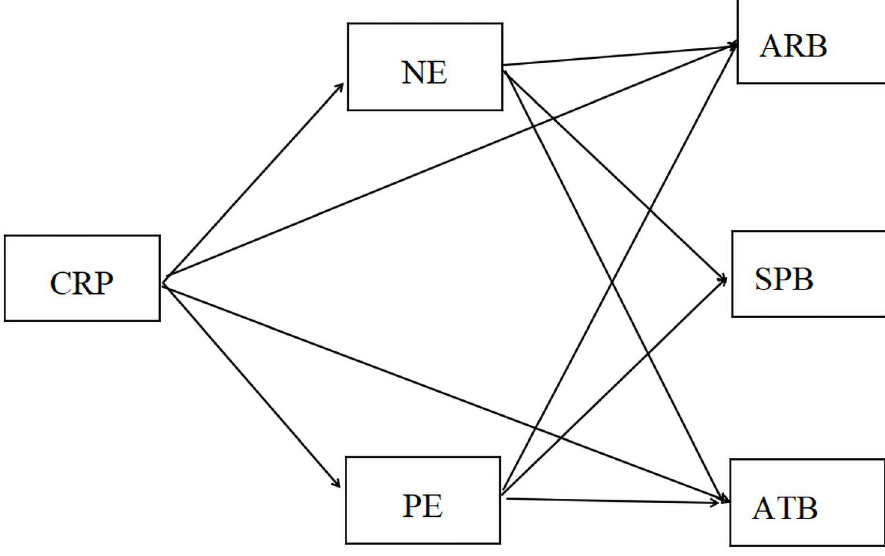
Fig 1. Concept model. SPB = Self-protection behaviour, PE = positive emotion, NE = negative emotion, ARB = Active-response behaviour, SPB = Self-protection behaviour, CRP = COVID-19-related risk perception, RTB = Risk-taking